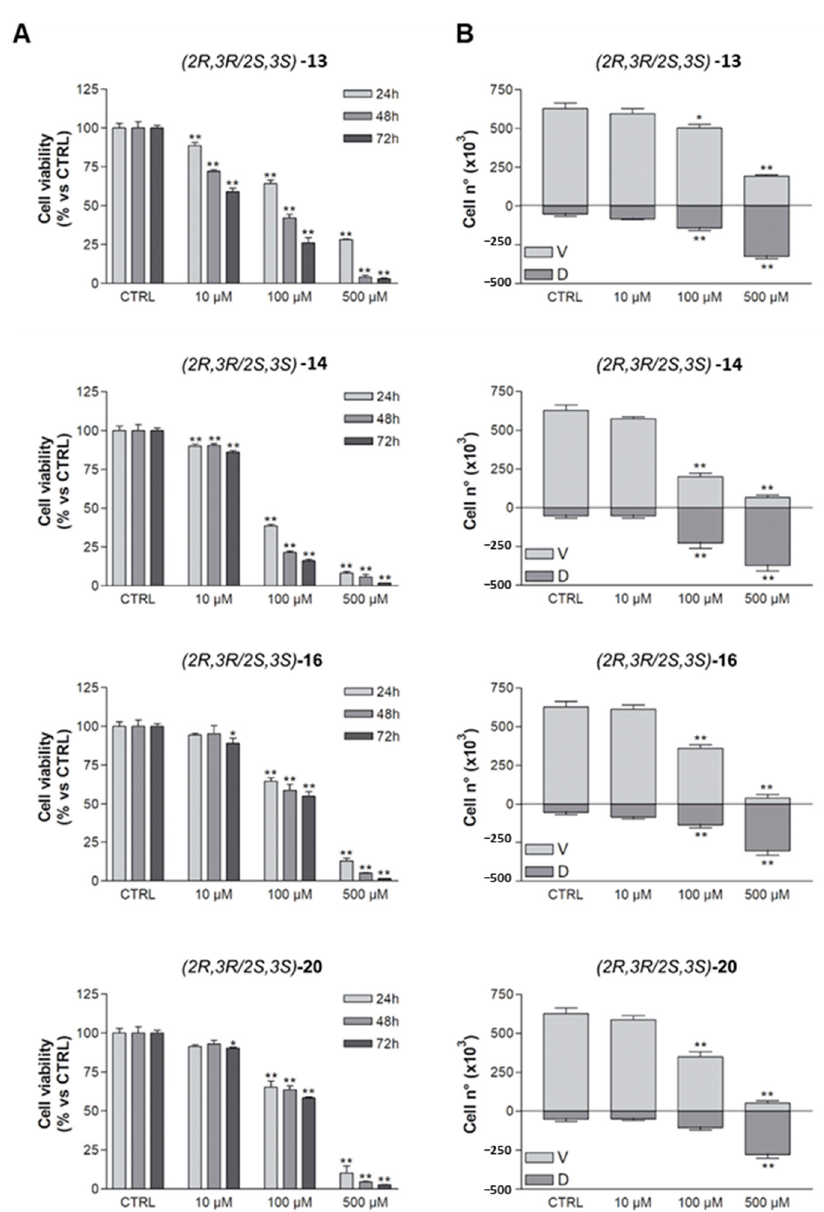
Figure 5. ( A ) MTT assay of ( 2R,3R/2S,3S )- 13 , 14 , 16 and 20 in RPMI 8226 cells. Cells were not treated (CTRL) or treated with different concentrations of compounds (10, 100 and 500 µ M) for 24, 48 and 72 h; The graphs represent the mean percentage ± SD of cell viability, compared to untreated controls, arbitrarily set to 100%. * p < 0.05 and ** p < 0.01 vs. CTRL; ( B ) Trypan blue vital count assay of RPMI 8226 cells treated with (2R,3R/2S,3S) - 13 , 14 , 16 and 20 . Cells were not treated (CTRL) or treated with different concentrations of compounds (10, 100 and 500 µM) for 24, 48 and 72 h. The graphs represent the mean cell number ± SD of viable and dead cells. * p < 0.05 and ** p < 0.01 vs. CTRL.